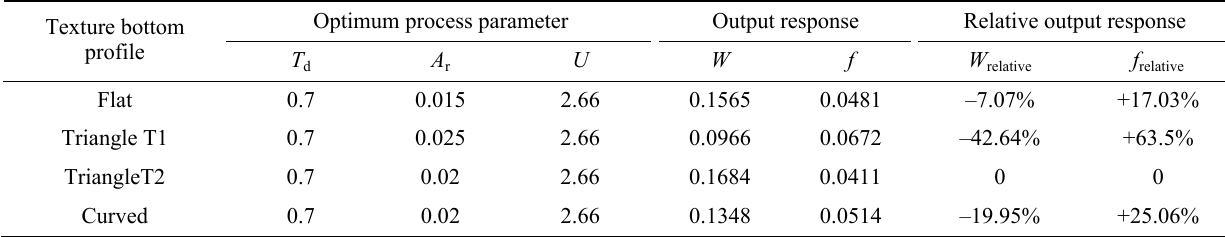
Table 12 Comparative analysis of optimized bottom profile